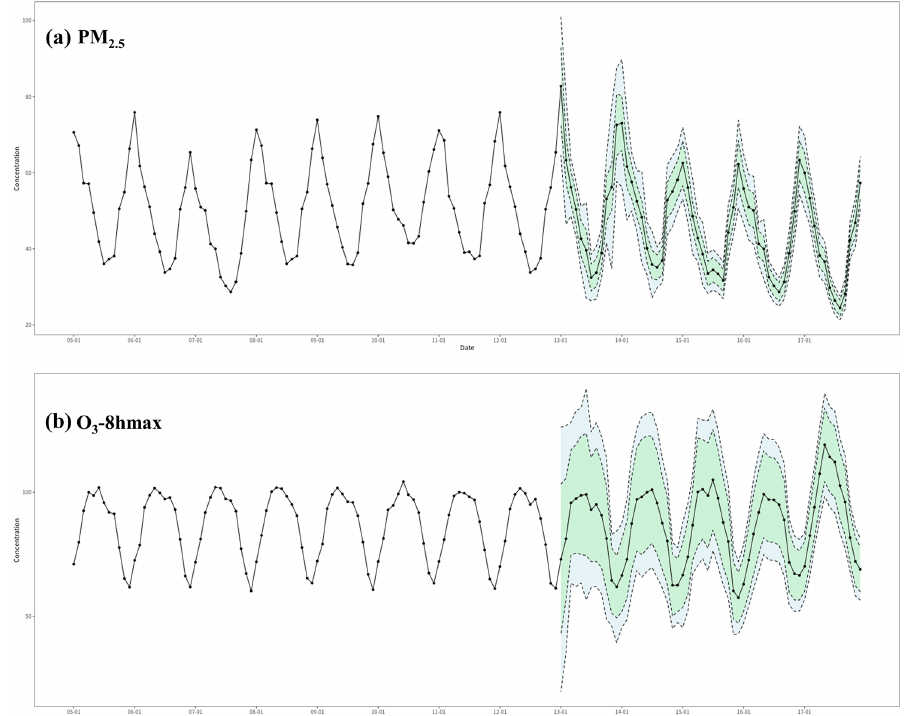
Figure 5. The temporal trend of PM 2 . 5 and O 3 -8hmax concentration in China from 2005–2017. The black dots represent the monthly average PM 2 . 5 and O 3 -8hmax concentration from 2005 to 2017, the blue color band represents the range of the monthly average PM 2 . 5 and O 3 -8hmax concentration plus or minus the RMSE value from 2013–2017 (period with monitoring data), and the green color band represents the range of the monthly average PM 2 . 5 and O 3 -8hmax concentration plus or minus the MAE value from 2013–2017